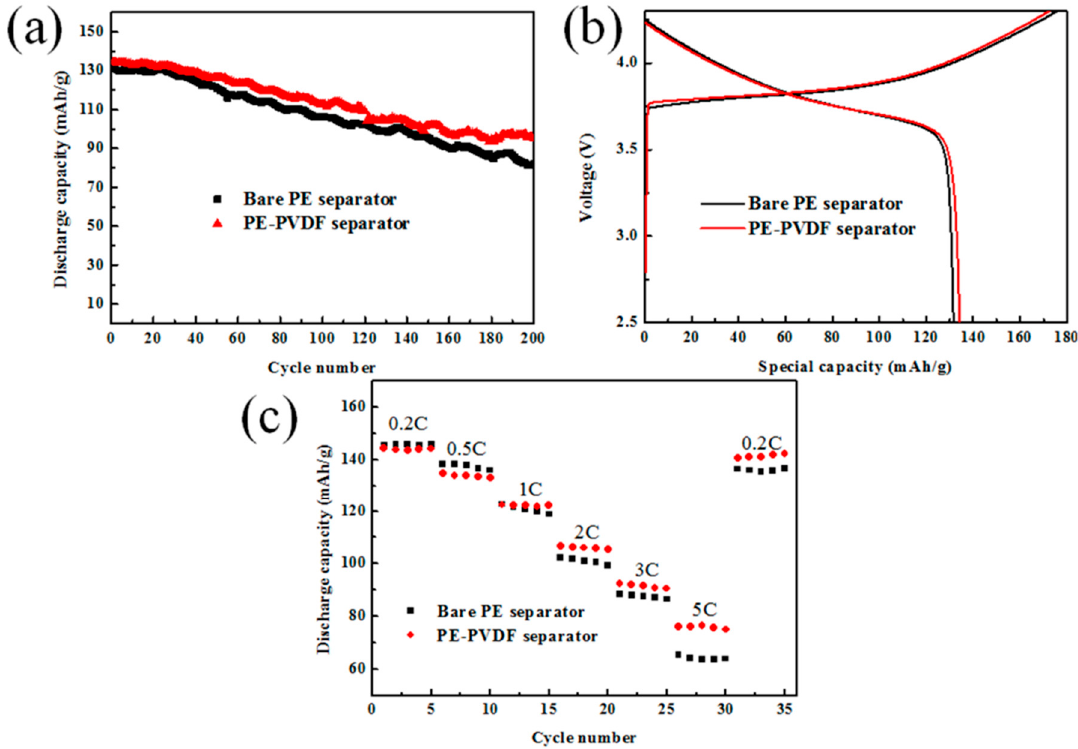
Figure 8. ( a ) The cycle performances; ( b ) first charge-discharge curve; ( c ) rate capabilities of the cells with bare PE and PE-PVDF separators.